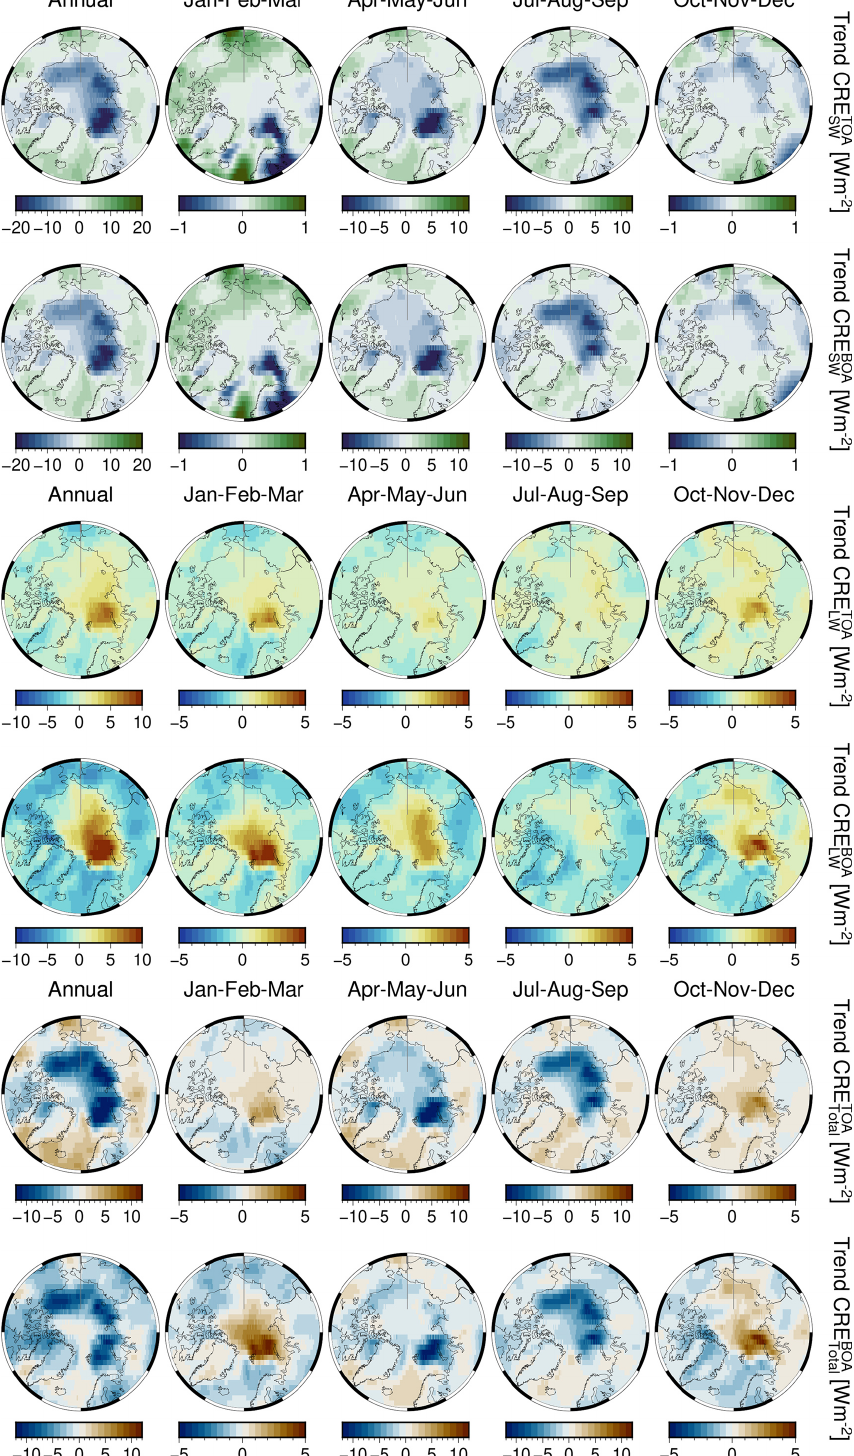
Figure G2. From left to right, annual and seasonal trends of SW (rows 1–2), LW (3–4), and total (5–6) cloud radiative forcing (CRF, Wm − 2 ) at TOA and